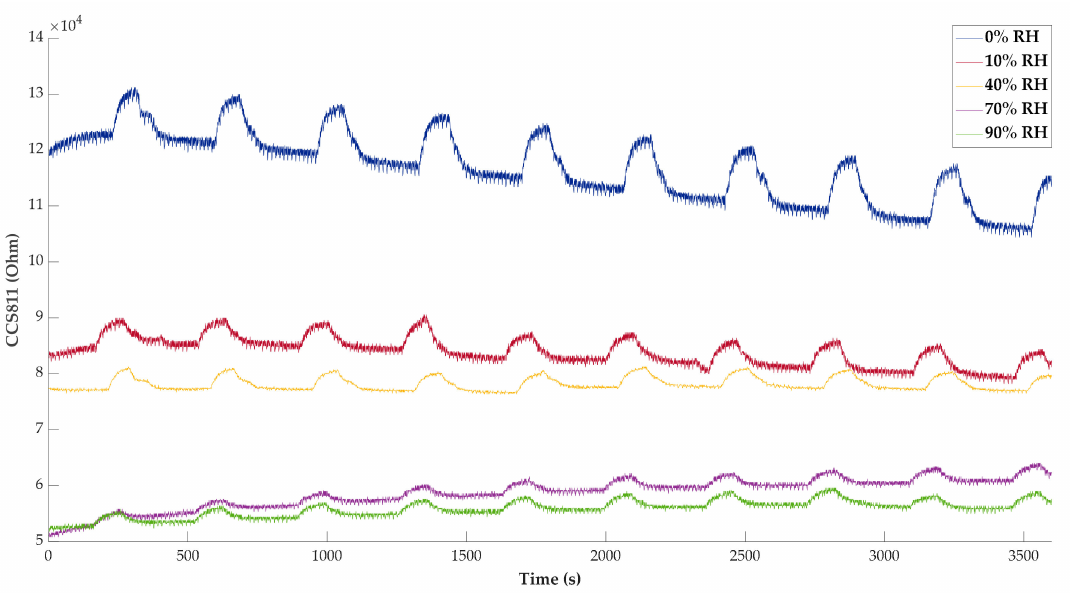
Figure 12. Time responses of sensor CCS811 ( Ω ) at di ff erent relative humidity